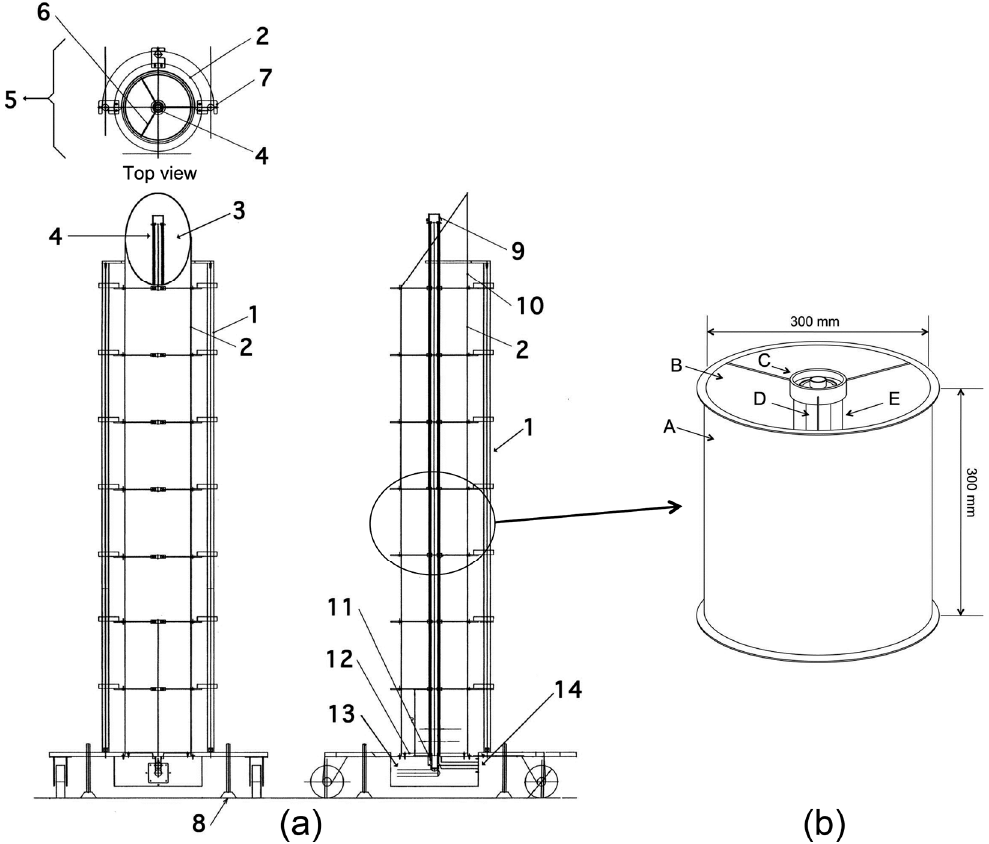
Figure 10. ( a ) Diagram of the solar tower reactor. 1: support rod; 2: cylindrical